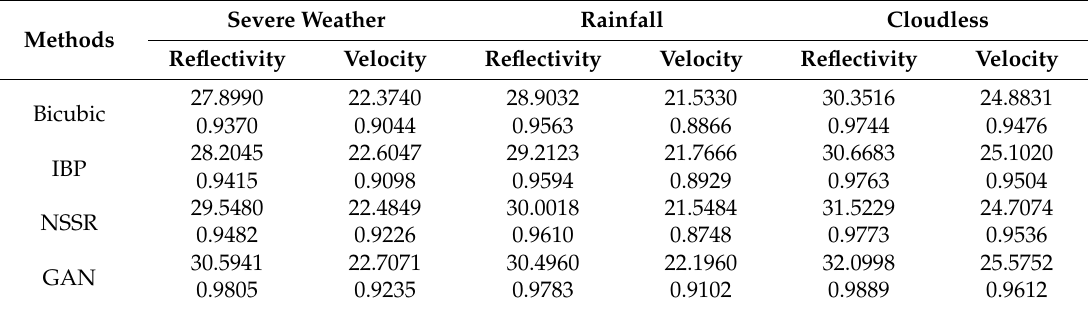
Table 2. Average PSNR (dB) and SSIM results of the reconstructed echo of five groups of level-II data products of the CINRAD-SA radar ( ×